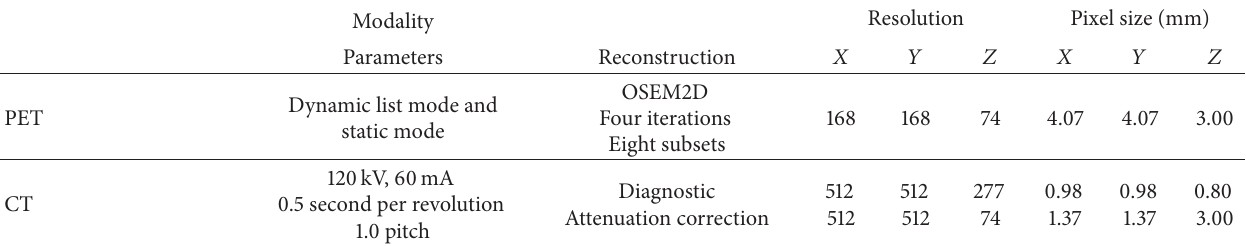
Table 2: PET and CT reconstruction